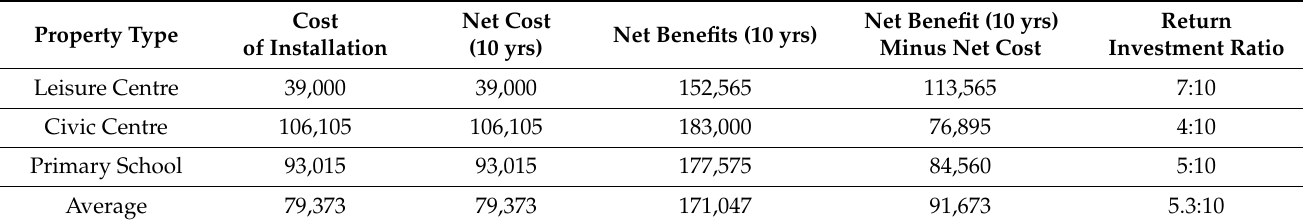
Table 2. CBA value of the SuDS retrofit